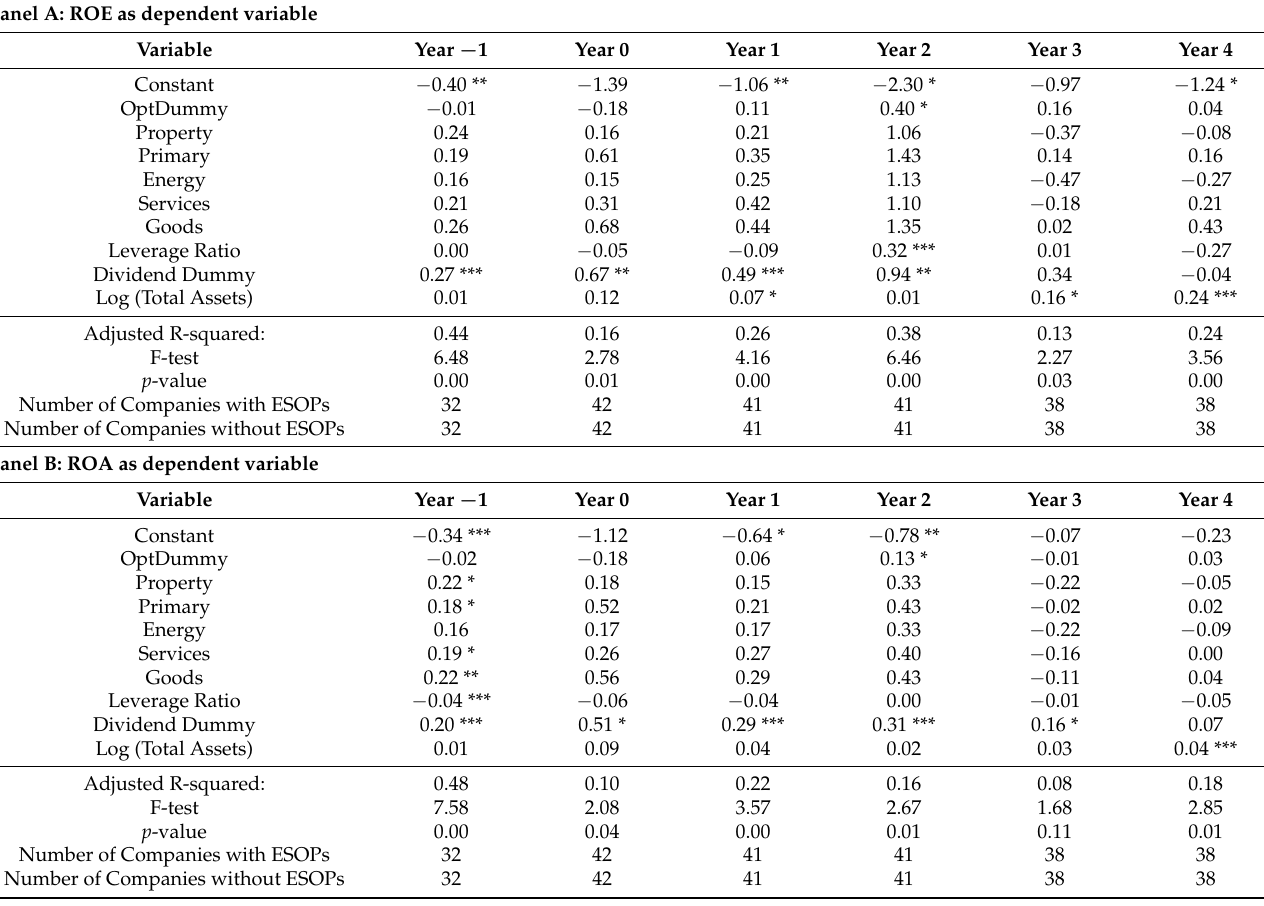
Table 5. ESOPs and ROE/ROA. This table shows the results based on ROE and ROA as an alternative proxy for firm performance, which are reported in panels A and B, respectively. Panel C consists of three sub-tables that report the vesting period effects. Tobin’s Q in Panel C1, ROA in Panel C2 and ROE in Panel C3 are the test results after considering vesting period effects. OptDummy is the ESOPs dummy variable. Other control variables involve log (total assets), leverage ratio and dividend dummy, and five industry dummies. The table also reports the t-statistics below each variable and the five bottom lines of the table are adjusted R 2 , F-statistics and p -value. Year − 1 refers to a year prior to the first announcement date of ESOPs; Year 0 is a year of the first announcement; and Year 1 to Year 4 represent the years after the announcement. *, ** and *** are 90%, 95% and 99% levels of significance,